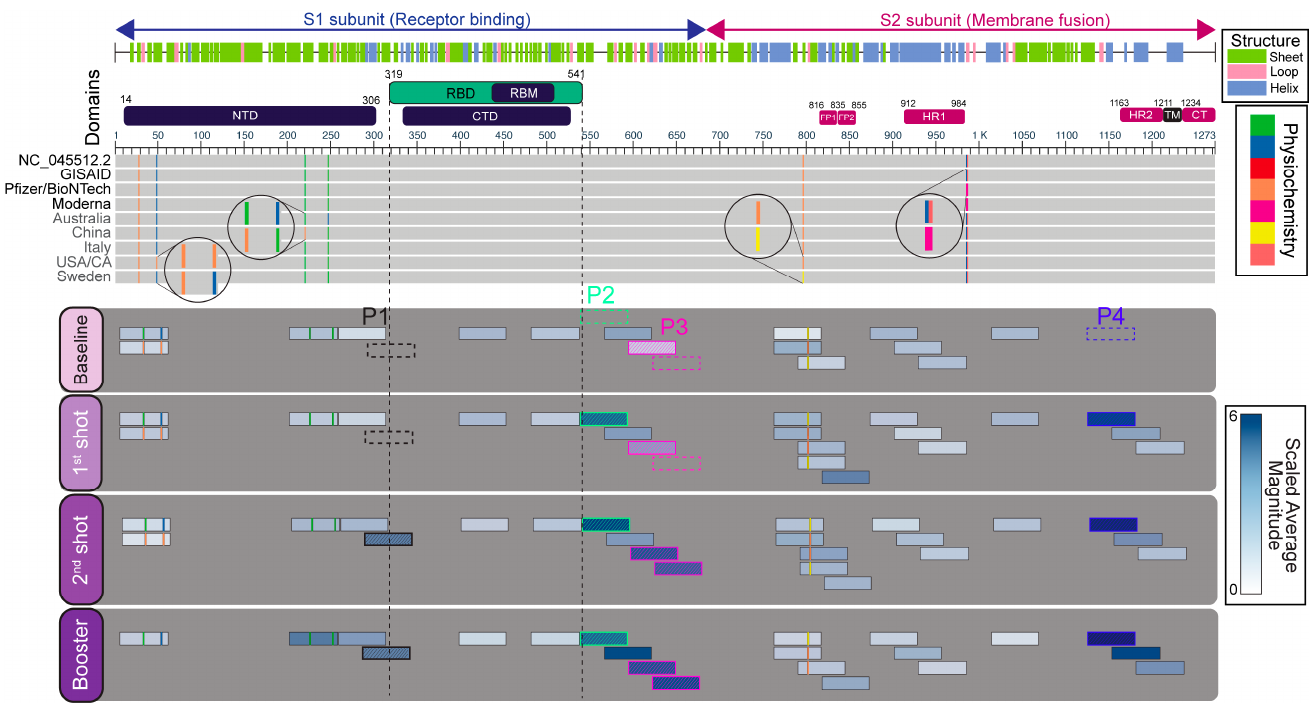
Figure 3. Epitope map of anti-S responses represented as scaled average magnitudes. The multiple sequence alignment (MSA) of full-length SARS-CoV-2 spike glycoprotein reference, vaccine, and input library sequences are shown, where regions in light grey represent sequence conservation. Mismatched residues are highlighted and color-coded using the pre-defined Zappo scheme (green: hydrophilic, salmon: aliphatic/hydrophobic, orange: aromatic, fuchsia: conformationally special, yellow: cysteine only, red: negatively charged, blue: positively charged). Reactive peptides are mapped and colored based on scaled average magnitudes (blue gradient) across timepoints. Vaccine-boosted epitopes are indicated (P1–P4). Peptides with transparent backgrounds and dashed borders indicate absence of baseline responses and are only shown for convenience. Abbreviations: NTD: N-terminal domain, CTD: C-terminal domain, RBD: Receptor-binding domain, RBM: Receptor-binding motif, FP1/2: Fusion peptide 1/2, HR1/2: Heptad repeat 1/2, TM: Transmembrane, CT: Cytoplasmic tail.